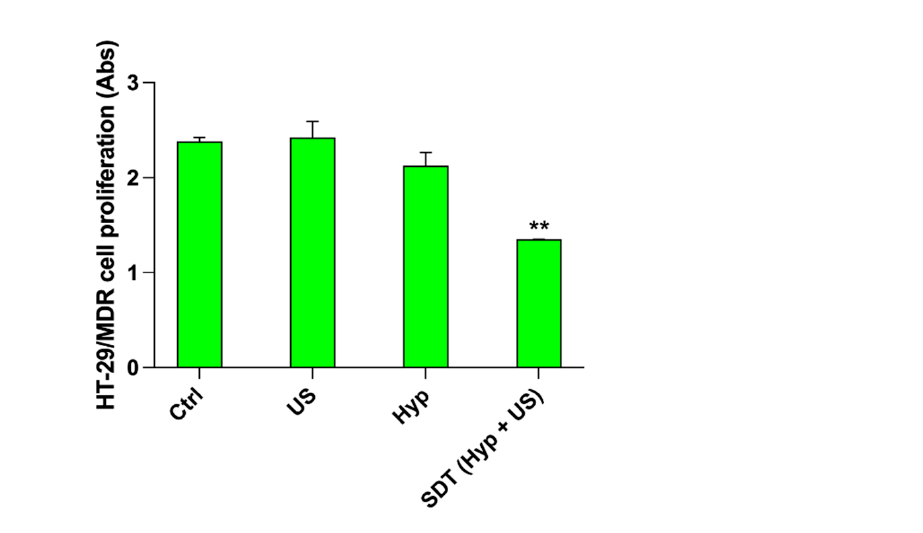
Figure 11. Effects of Hyp-mediated photodynamic treatment on HT-29 spheroids. ( a ) Representative optical (bright field) and fluorescence (PI staining in red) images that were acquired 48 h after the spheroid treatment as follows: untreated spheroid, spheroid incubated with 0.2 μ M Hyp, spheroid exposed to LB (green led at 1.5 W/cm 2 for 20 min), and spheroid treated with PDT (0.2 μ M Hyp +